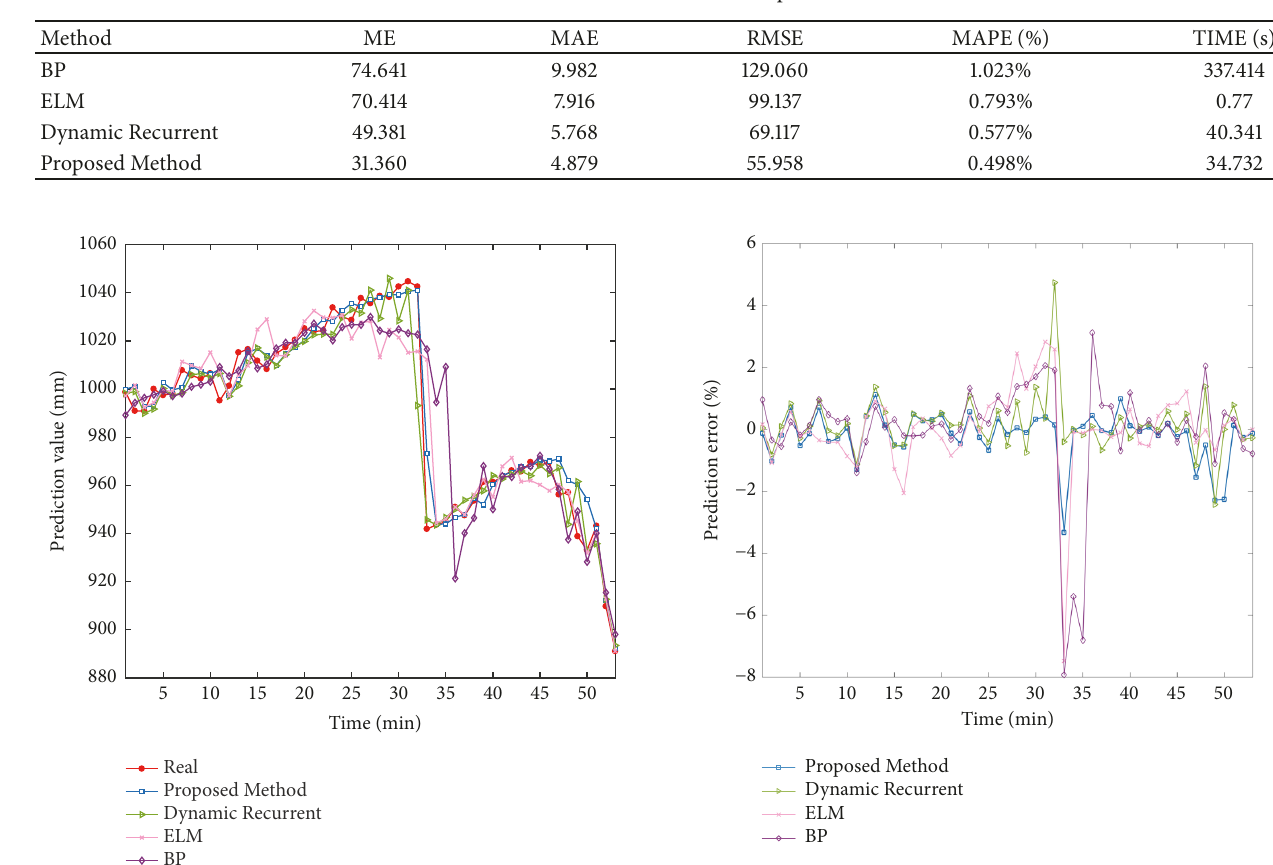
Table 9: Performance evaluation of different prediction models.